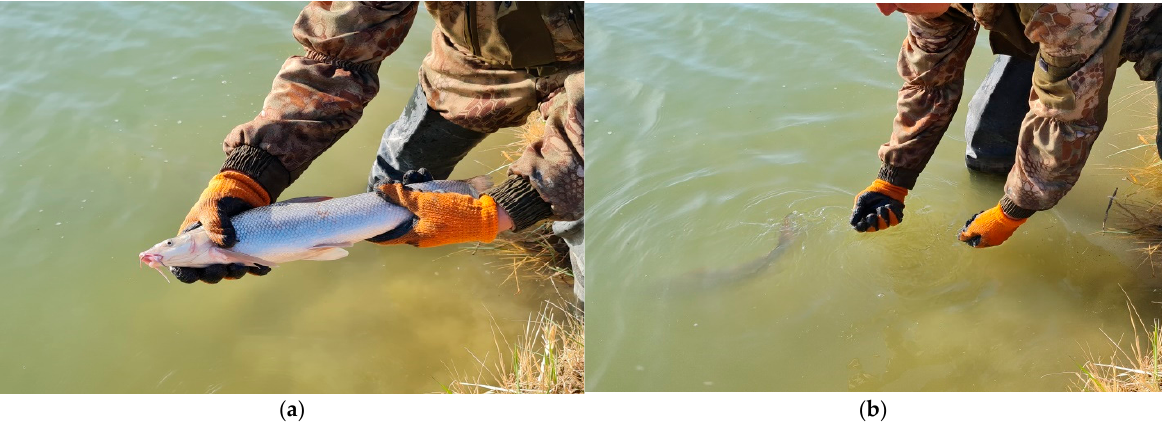
Figure 2. Collecting Aral barbel in the retaining zone of the Aral (Small) Sea: ( a ) one of the indi- viduals caught in Small Aral Sea, 2021; ( b ) release of the barbel after biological measurements.